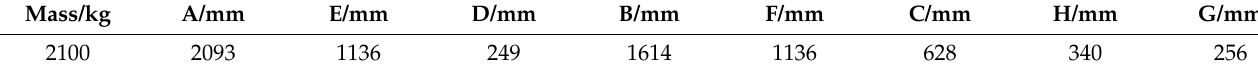
Table 4. The specifications of Hall anchor.